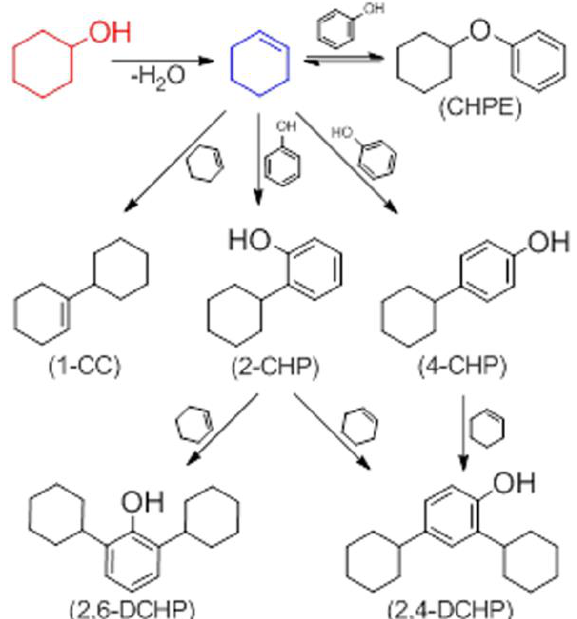
Figure 5. A simplified reaction network for the alkylation of phenol with cyclohexanol in decalin. Reproduced from [96], with the permission of Elsevier.